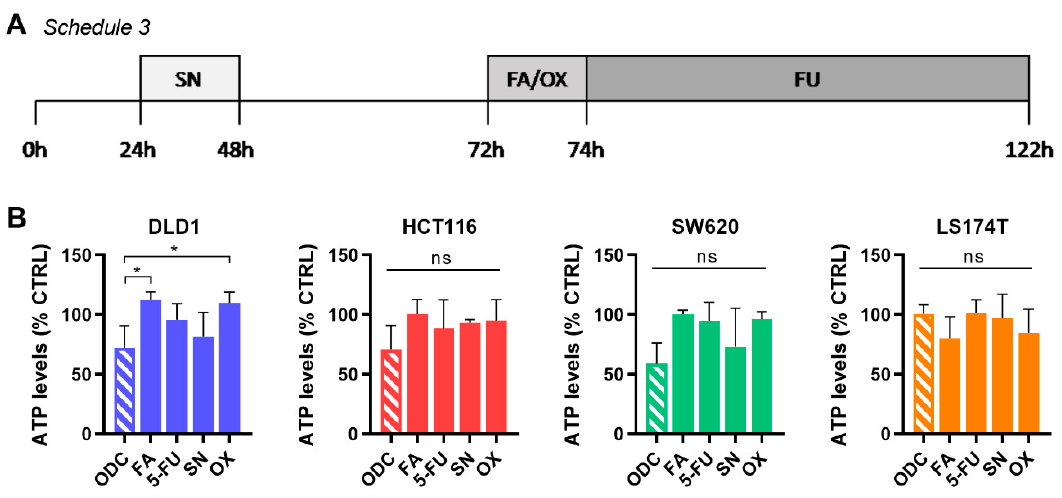
Figure 6. Validation of the drug combinations in a clinically used drug administration schedule. ( A ) Schematic representation of an intermittent drug administration schedule extrapolated from a clinical setting (Schedule 3). CRC cells were seeded and kept without treatment for 24 h. Afterward, the culture medium was removed to apply SN for 24 h, followed by the removal of used cell culture medium and addition of fresh medium for another 24 h. Starting at 72 h post-experiment initiation, the cell culture medium was replaced by a combination of FA/OX, kept for 2 h, and then replaced by 5-FU for another 48 h. The entire procedure lasted for 122 h. ( B ) Drug combination efficacy on cell metabolic activity in each of the cell lines. Error bars represent the SD for N = 3 experiments and significances of * p < 0.05 represent the comparison with the full combination for all cell lines by a one- way ANOVA with post-hoc Dunnett’s multiple comparisons test.